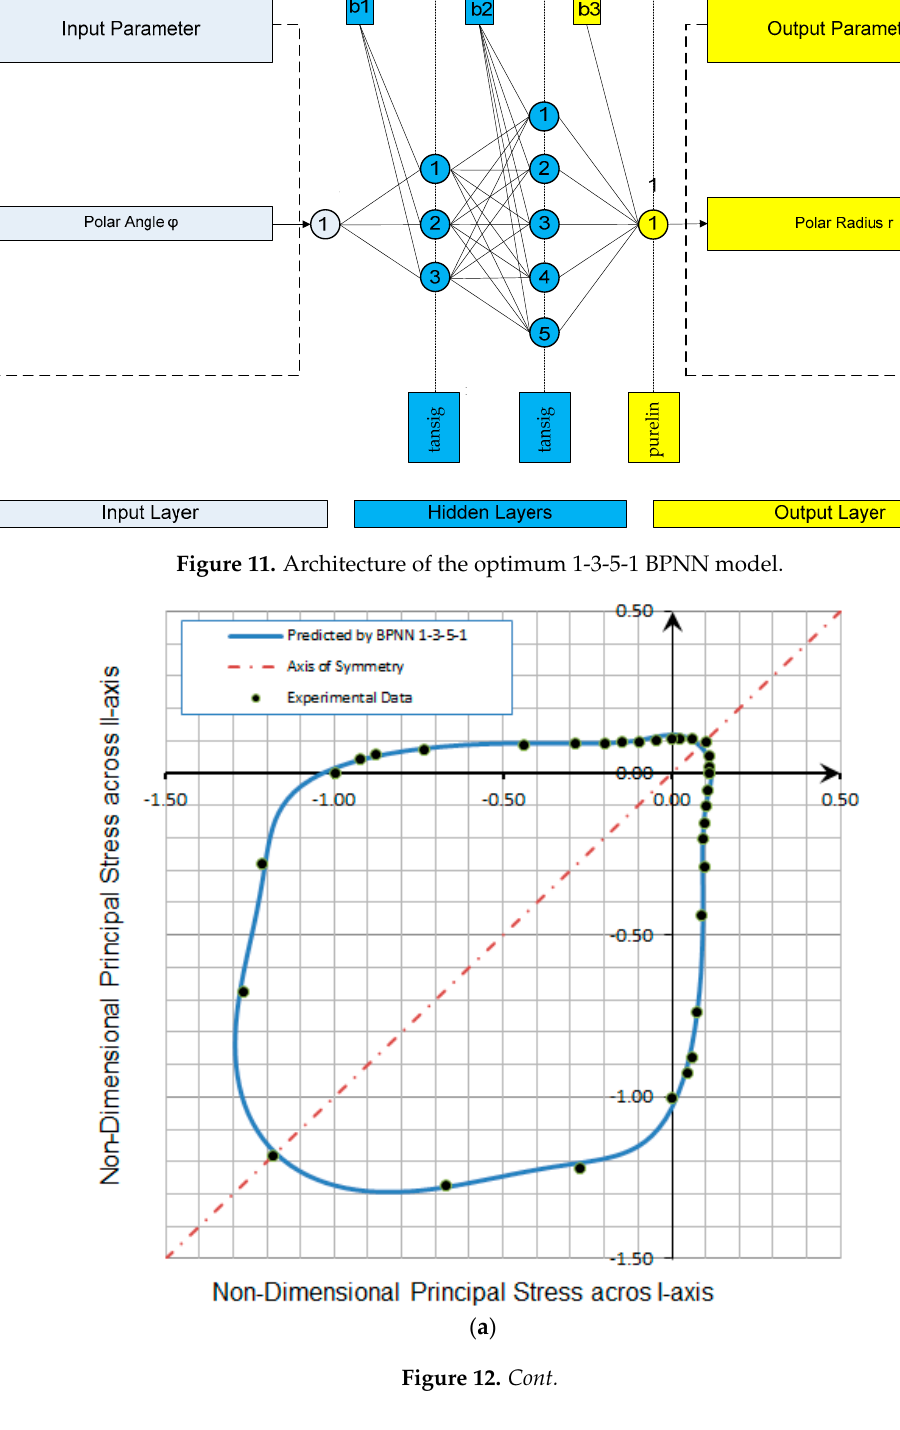
( b ) Figure 12. Concrete failure criterion under biaxial stress state: ( a ) in dimensional principal stresses terms; and ( b ) in polar coordinates.